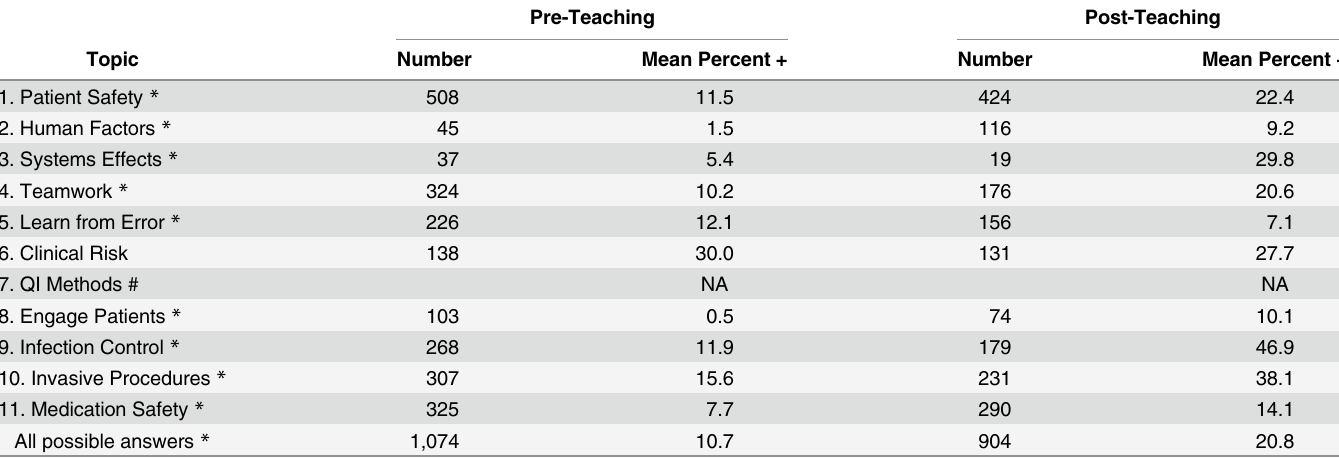
Table 4. Differences in Students Knowledge of Patient Safety, Before and After